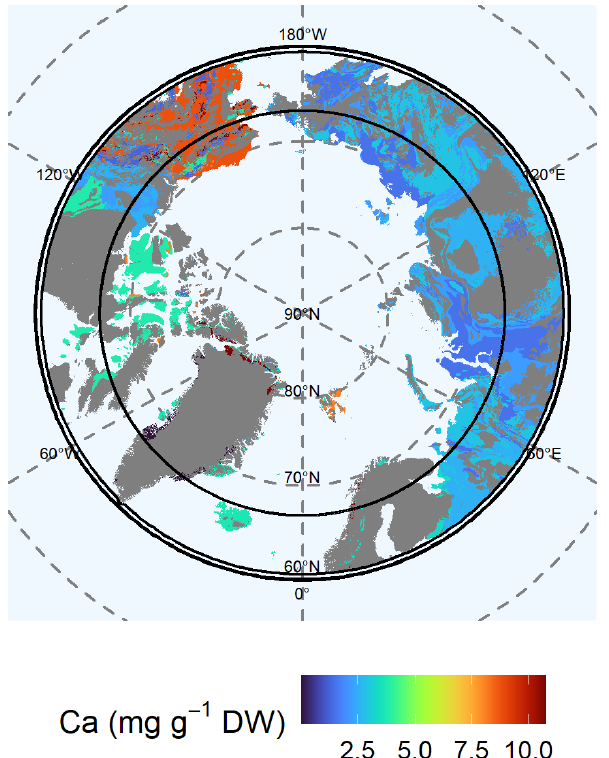
Figure 6. Map of the mean concentration of available (Mehlich- III-extractable) iron (Fe) for the uppermost 100cm of soils. For each lithological class, the mean concentration is shown. Blue colors rep- resent low concentrations of Fe, whereas red colors represent high concentrations Gray shaded areas are not represented by our